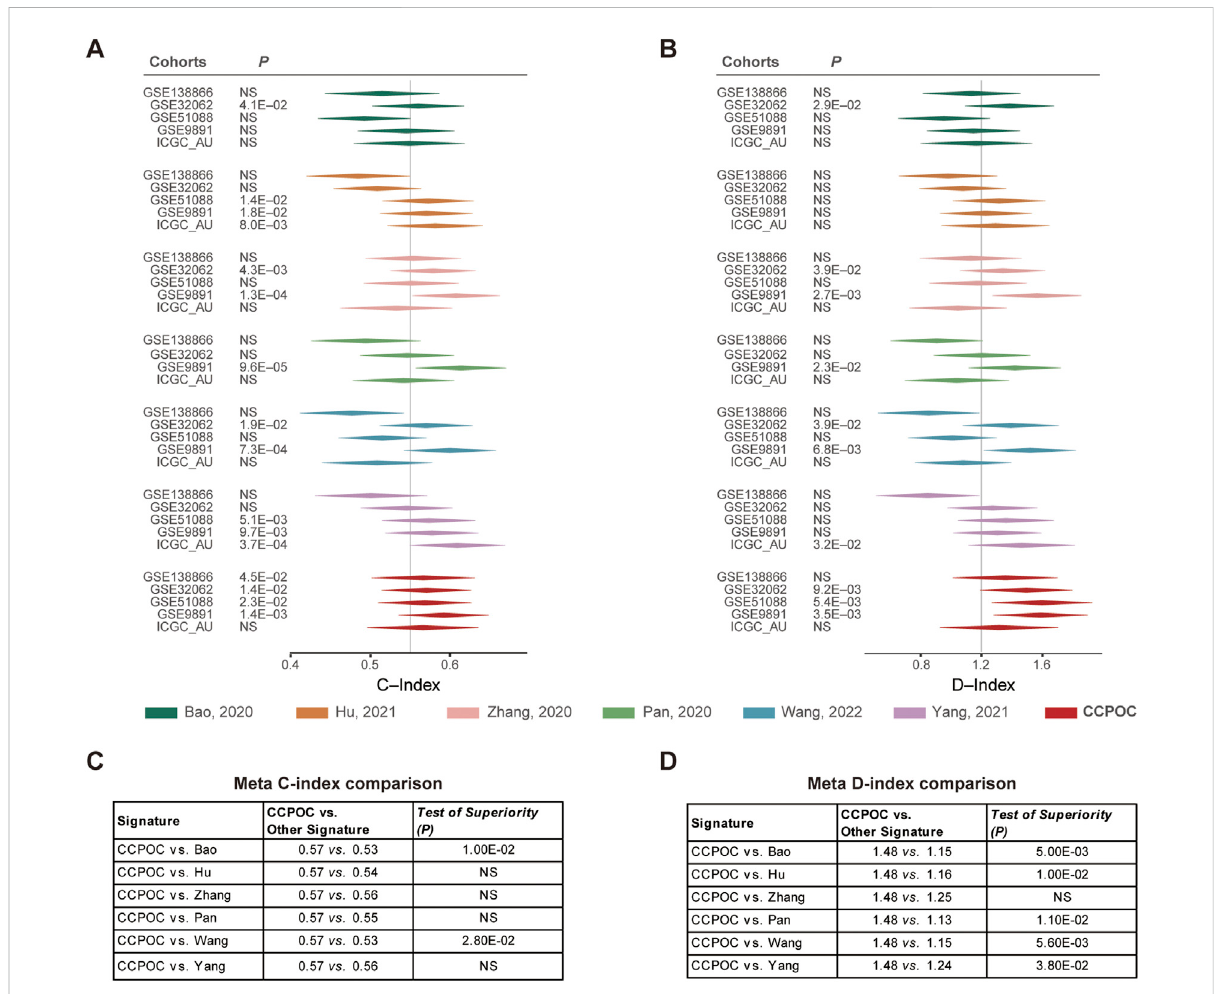
FIGURE 4 Comparison of published classi fi ers with CCPOC. Forest plot reporting of the (A) concordance index (C-index) and (B) D-index (robust hazard ratio) for CCPOC and published classi fi ers. The tables illustrate the superiority of CCPOC compared with published classi fi ers for Meta C-index (C) and Meta D-index (D)